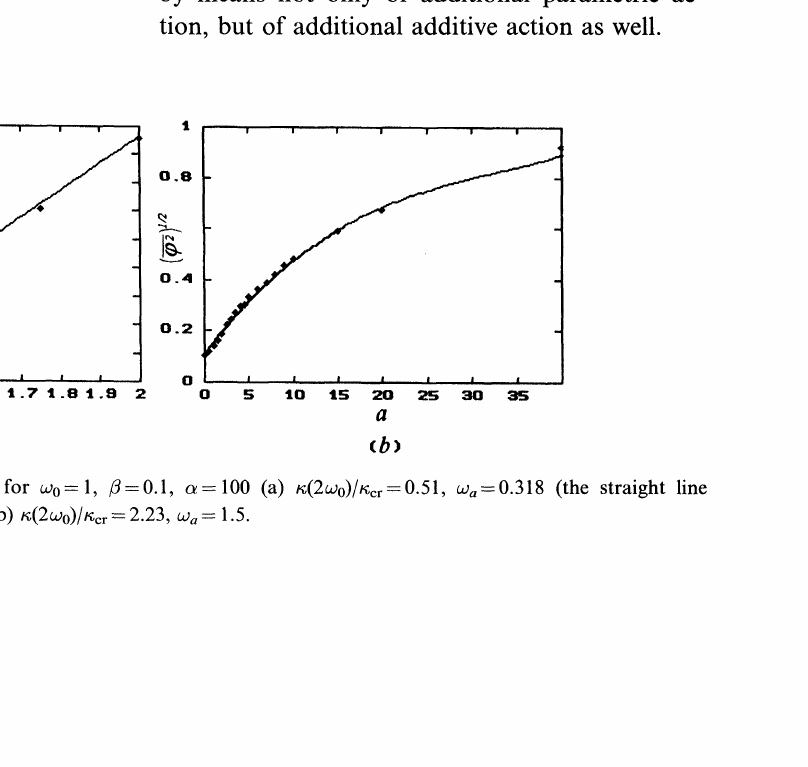
FIGURE 3 The dependencies of o 21/e on a for o0--1, /3--0.1, --100 (a) (2w0)/cr:0.51, 0Va’--0.318 (the straight line I/2 0.48 qo